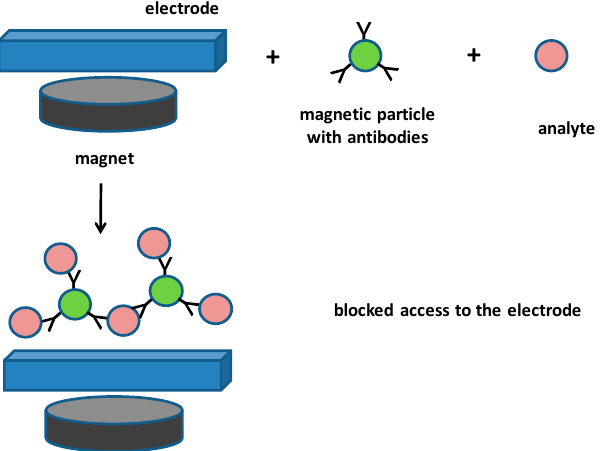
Figure 2. Simplified principle of magnetic particles blocking access to the electrode surface. It is a type of assay as described in the cited work [76].